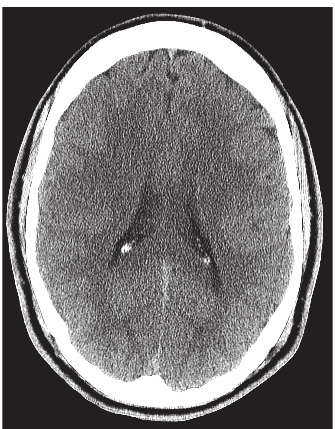
Figure 1: CT of the brain without contrast shows no intracranial abnormalities.